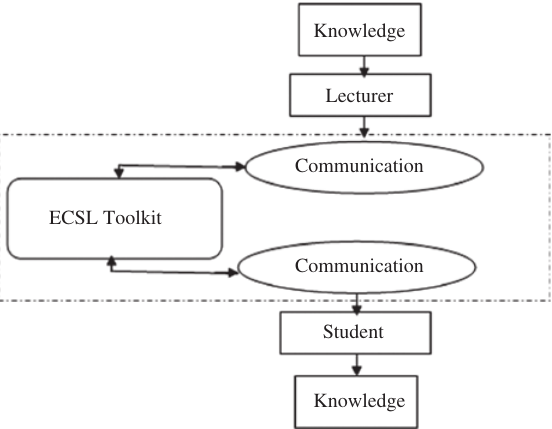
Figure 5. Educational Model Using E-mail as Communication and ECSL